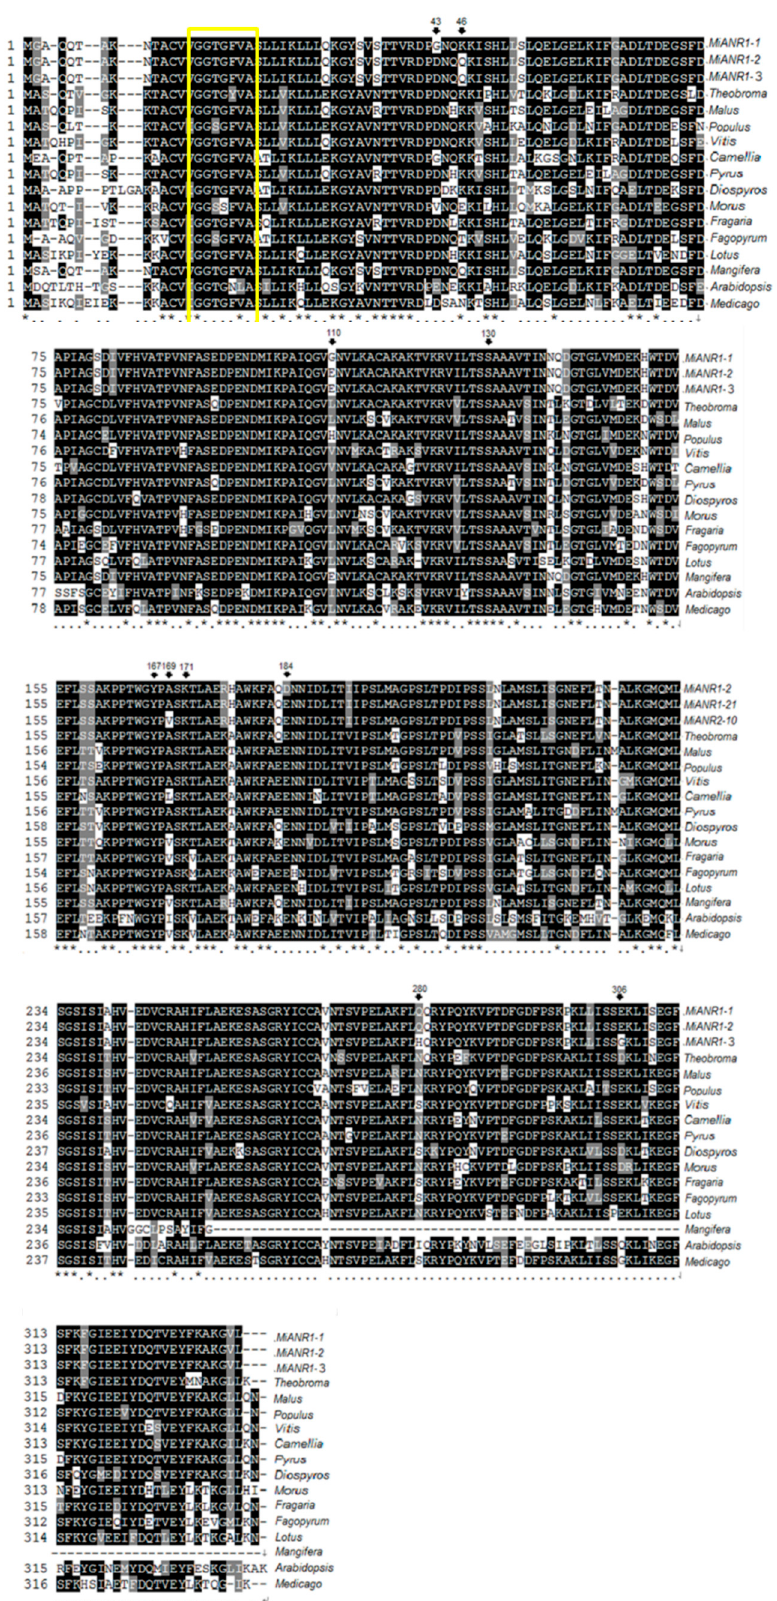
Figure 2. A sequence alignment of MiANR1-1,1-2 and 1-3 with ANR homologs from plants generated using Constraint-based Multiple Alignment Tool. Mangifera represents mango Iwin, * indicates the same amino acid in all 17 sequences. . shows semi-conservative amino acid in the 17 sequences. 43, 46, 110, 169, 184, 280, 306 indicates amino acid difference among MiANR1-1, 1-2 and 1-3.